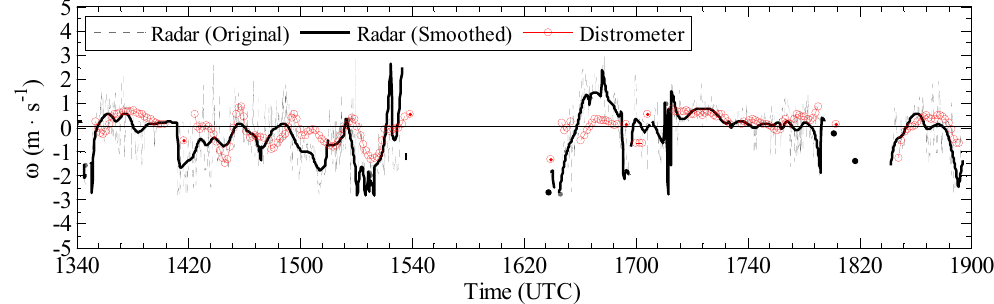
Figure 11. The time series of vertical air velocities derived by radar and disdrometer near the ground for case two, the radar retrievals are selected from the first detectable range gate at 150 m above the surface.